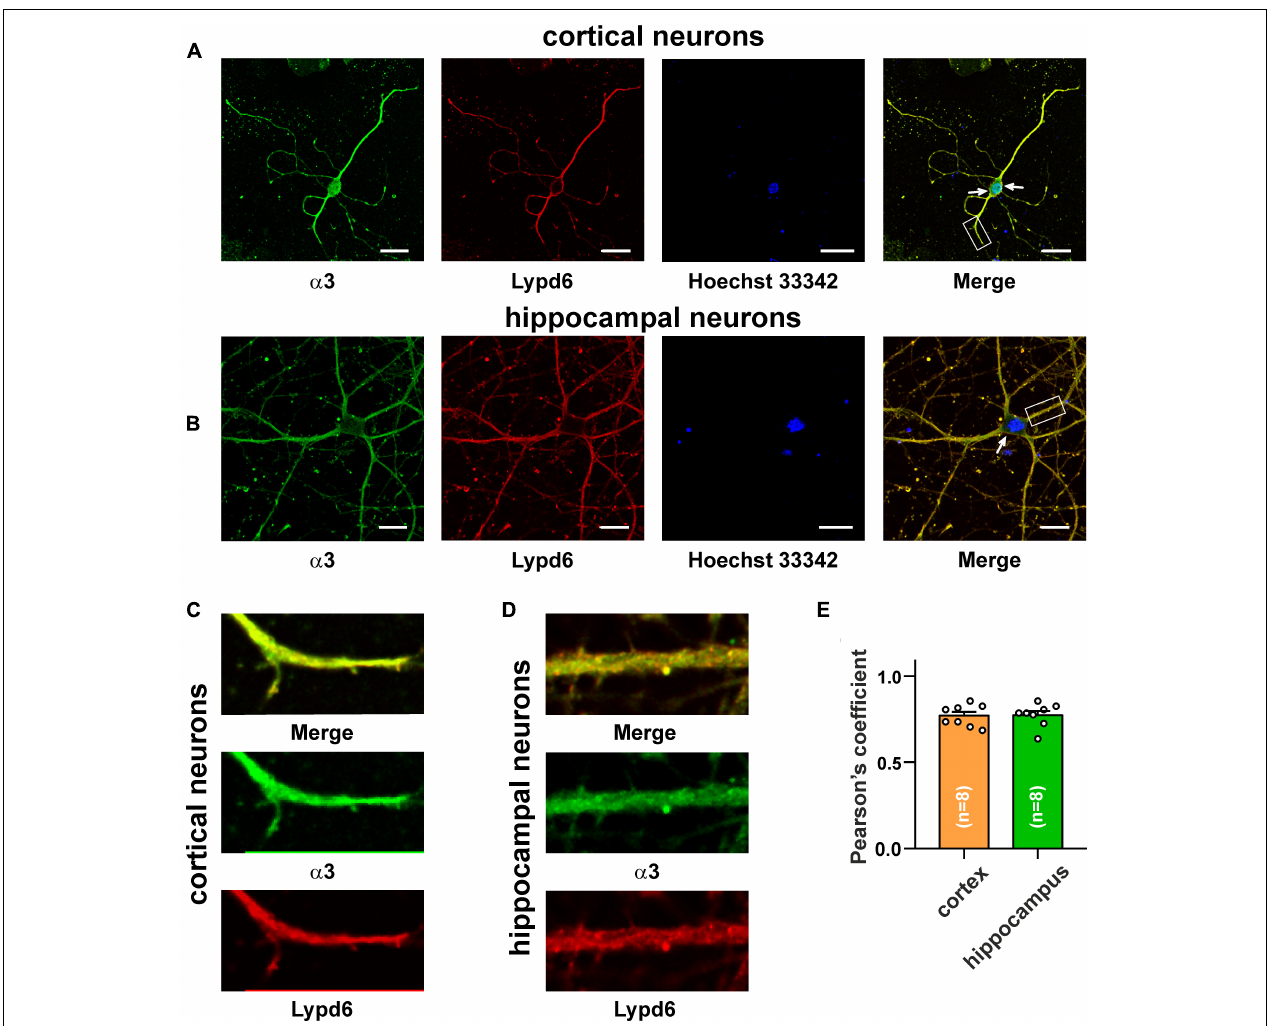
FIGURE 4 | Co-localization of endogenous Lypd6 and nAChRs containing α 3 subunit in primary cortical and hippocampal neurons. Cells were sequentially incubated with the mouse anti- α 3/rabbit anti-Lypd6 antibodies and secondary anti-mouse Alexa-488 (green)/anti-rabbit TRITC (red) labeled antibodies, respectively. (A,C) Colocalization of Lypd6 and the α 3 subunit in the cortical neurons. (B,D) Colocalization of Lypd6 and the α 3 subunit in hippocampal neurons. Scale bar 10 µ m. (C,D) Correspond to the enlarged fragments showed by white rectangles on (A,B) , respectively. Points with the different Lypd6 and α 3 expression are shown by arrows. (E) Pearson’s correlation coefficients of the Lypd6 and α 3 colocalization in primary cortical and hippocampal neurons ( n = 4,